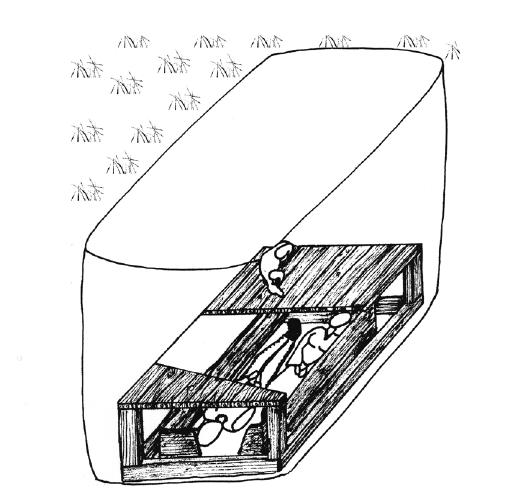
Figure 5: Chamber respectively wooden grave fixture in grave 140 (reconstruction drawing: Andreas Weihs)